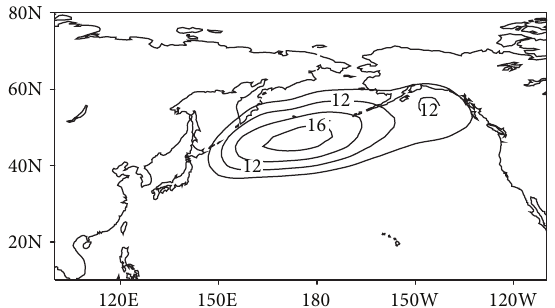
Figure 1: Spatial distributions of mean variance of synoptic-scale geopotential height (unit: dagpm 2 ) at 850 hPa in winter from 1948 to